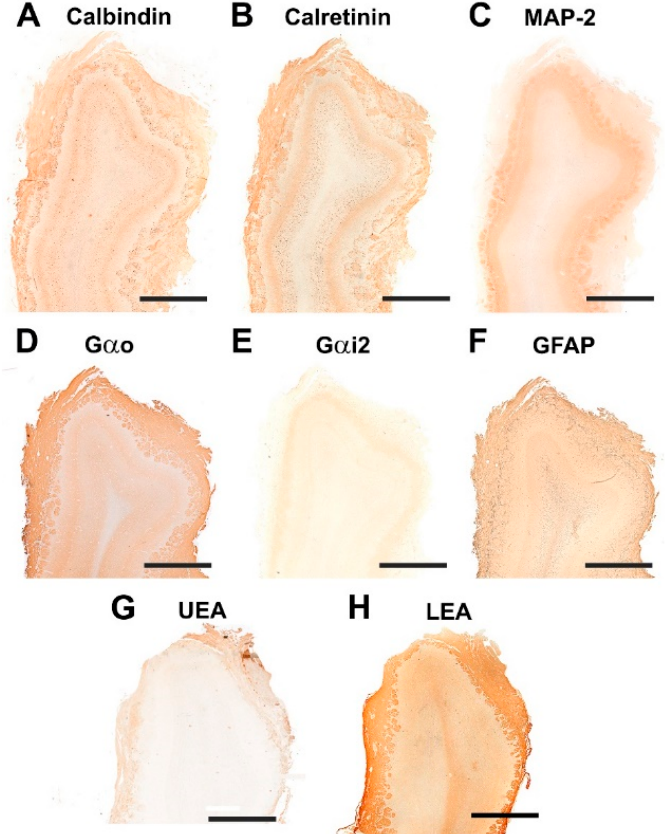
Figure 22. Immunohistochemical and lectin-histochemical study of the OB of the fox. ( A ) Anti-Calbindin; ( B ) Anti-Calretinin; ( C ) Anti-MAP-2; ( D ) Anti-Gao; ( E ) Anti-Gai2; ( F ) Anti-GFAP; ( G ) UEA histochemical labeling; ( H ) LEA histochemical labeling. Scale bars: 2 mm. Anti-MAP-2 (Figures 22C and 23D) produces in the glomerular and external plexiform layer strong labeling of the dendritic arbors originating from mitral cells, similar to that observed in the wolf and more intense than that described in the dog. This result corre- sponds to the greater morphological development observed with histological staining of mitral cells in wild canids. Anti-GFAP (Figures 22F and 23G) provides evidence of glial cell processes, and UEA lectin (Figures 22G and 23H) produces negative labeling in the OB of the fox, as was the case in dog and